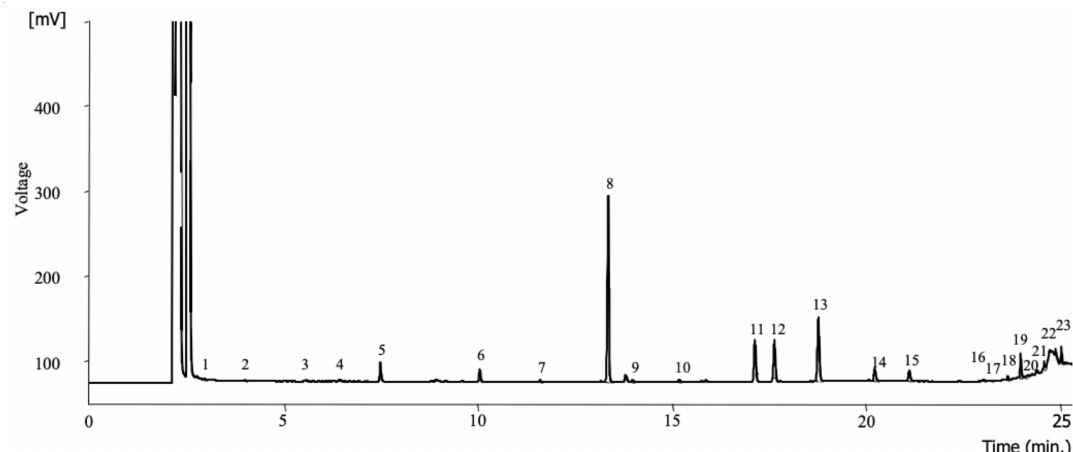
Figure 3. Chromatogram of fatty acids profile of Cynara cardunculus heads (sample Car